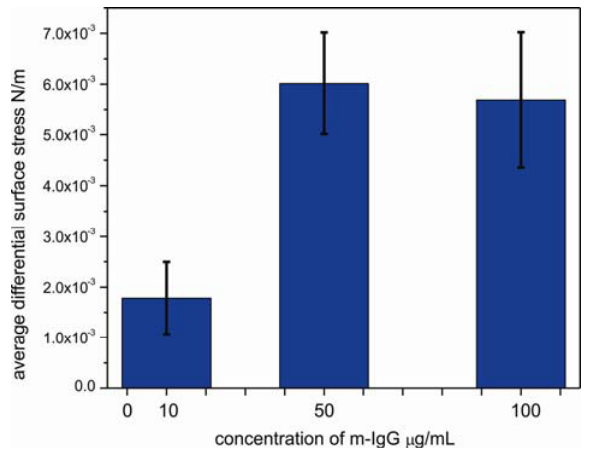
Figure 5. The average differential surface stress of sensor cantilever exposed to three various concentrations of m-IgG in separate